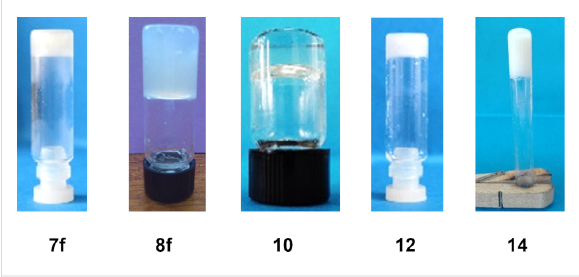
Figure 1: Tube inversion test: gels formed by compounds 7f , 8f , 10 , 12 , and 14 .